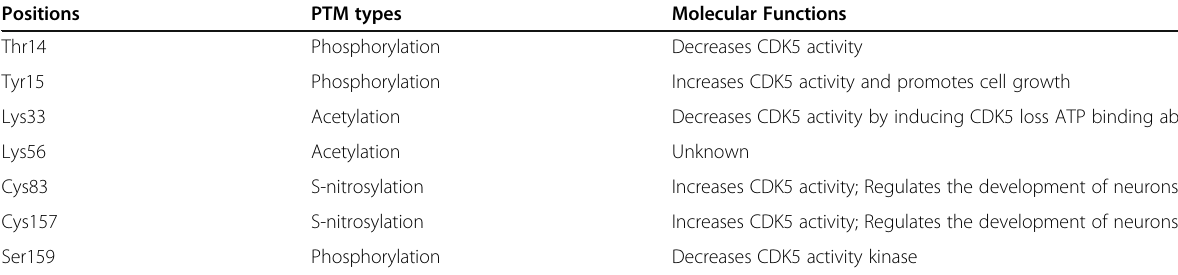
Table 3 PTMs on CDK5 and their relevant functions Positions